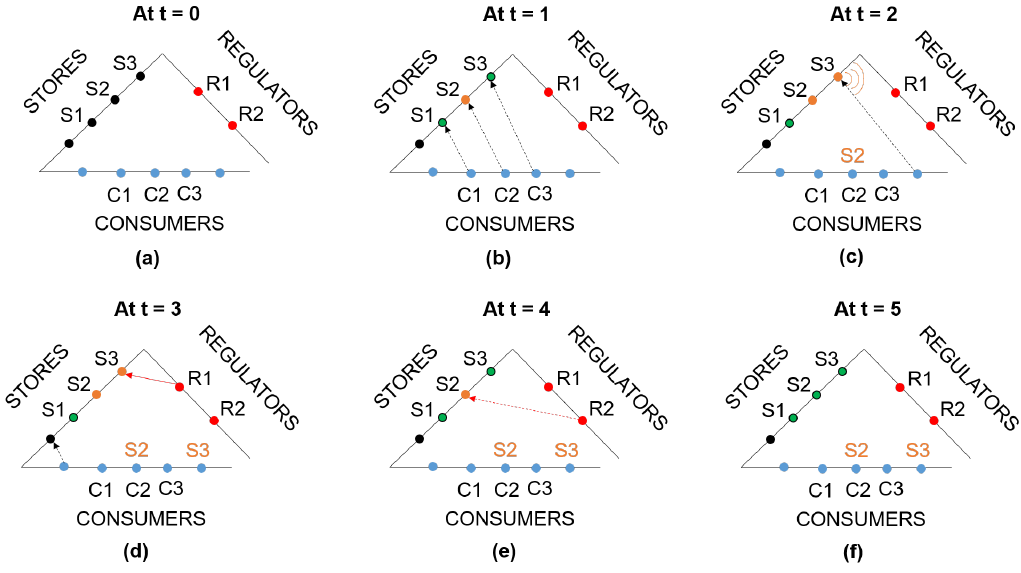
Figure 2. Conceptualization of Knowles Model using Routine Activity Theory. ( a ) At t = 0, ( b ) At t = 1, ( c ) At t = 2, ( d ) At t = 3, ( e ) At t = 4, ( f ) At t = 5.